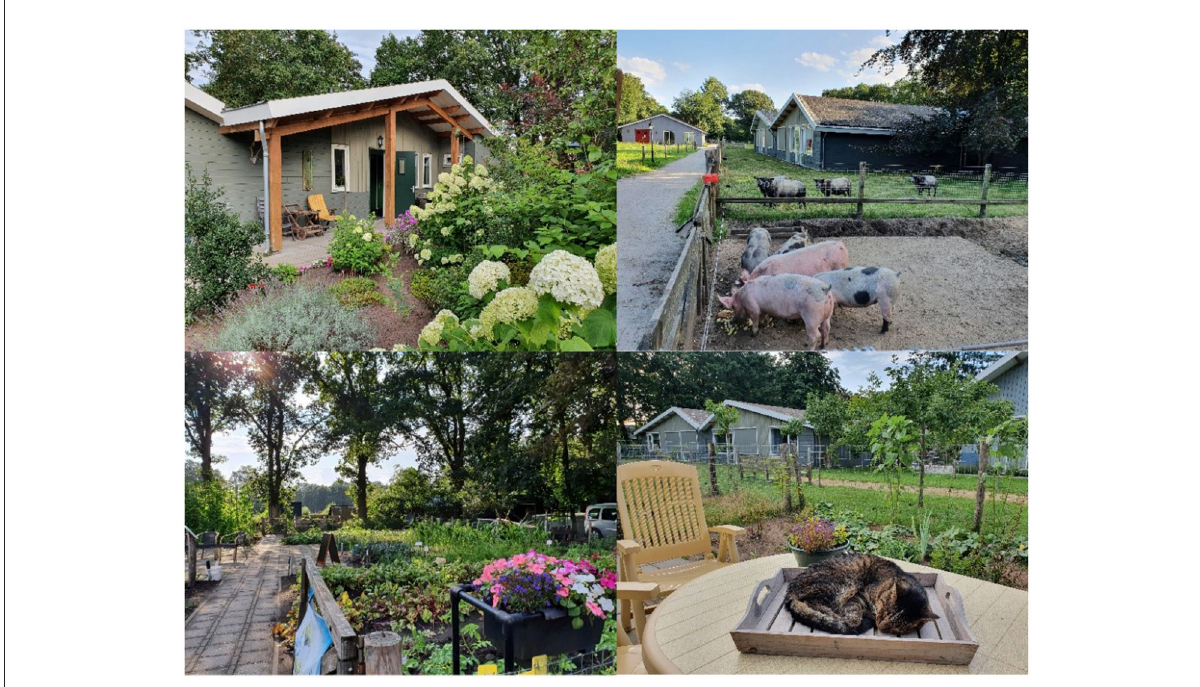
FIGURE1 Illustrative images of the Dutch Green Care Farm “ZorgErf